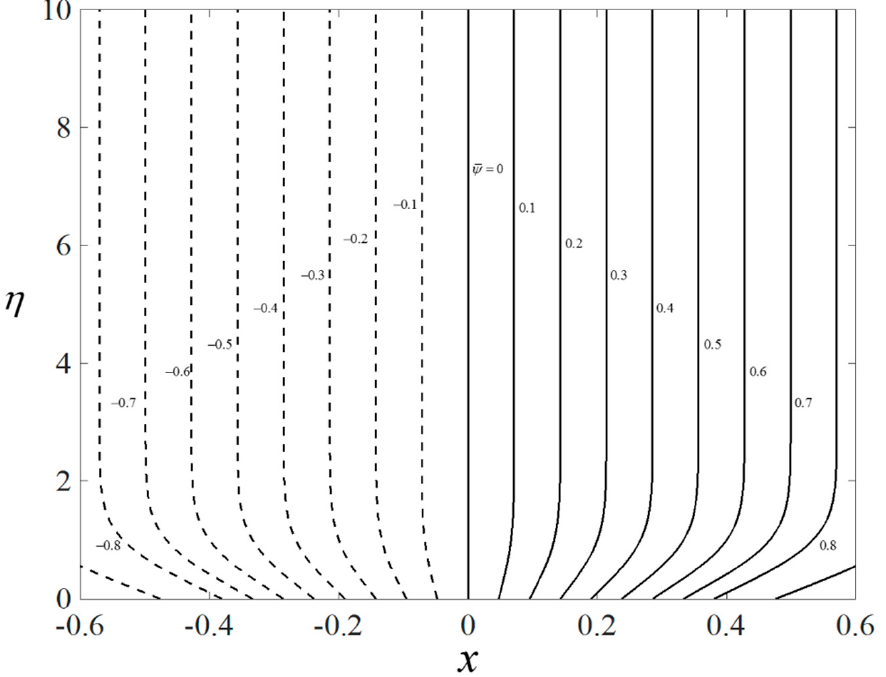
Figure 8. Plot of streamlines.